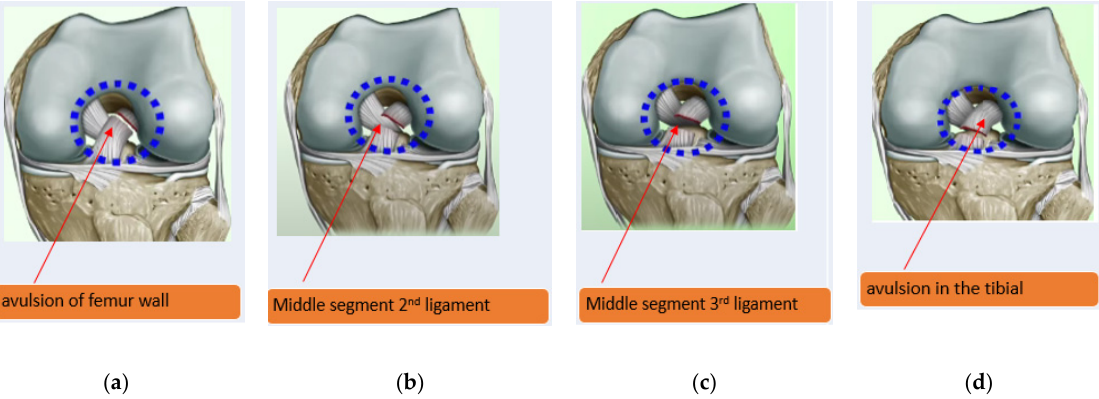
Figure 2. The four types of ACL tears; ( a ) type 1 avulsion of femur wall; ( b ) type II middle segment in 2nd ligament;( c ) type III middle segment in 3rd of the ligament; and ( d ) type IV avulsion in the tibial part [15] .